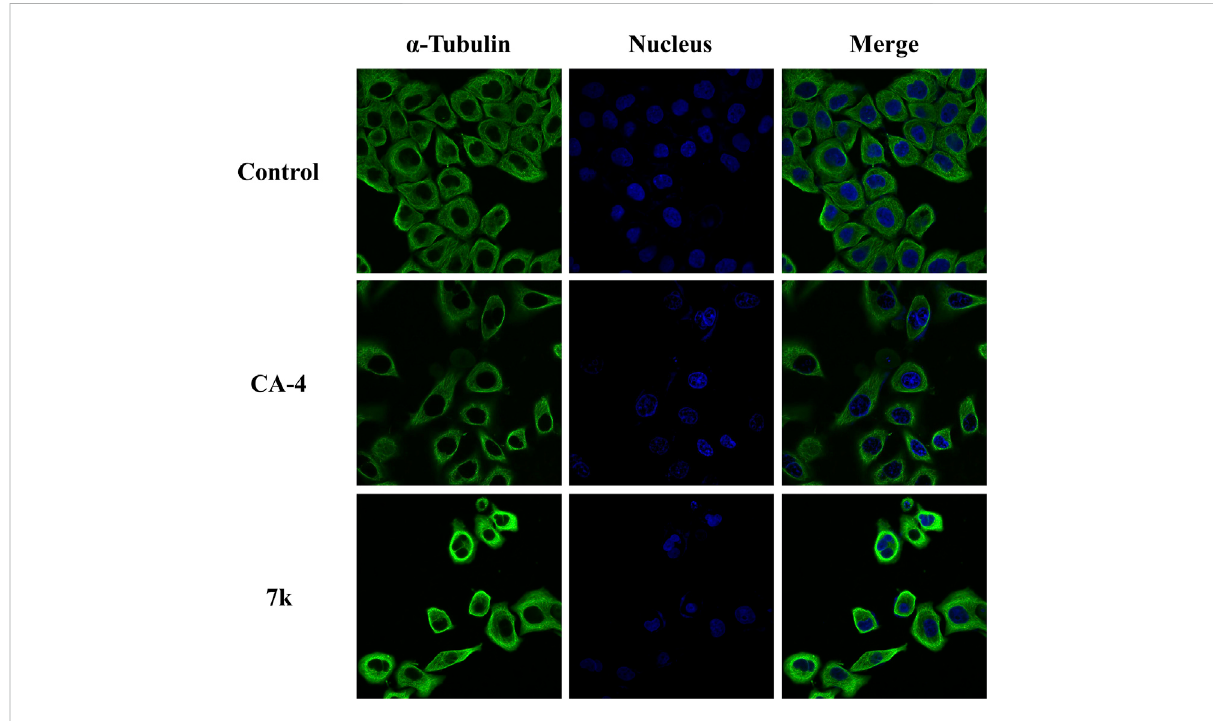
FIGURE 4 Effect of 7k and CA-4 on the microtubule network of HeLa cells. After treatment with control (vehicle DMSO), CA-4 at 1-fold IC 50 concentrations, and 7k at 2-fold IC 50 concentrations for 24 h, cells were stained with FITC-conjugated anti- α -tubulin antibody and DAPI. Microtubules and unassembled tubulin are shown in green, and the nucleus is shown in